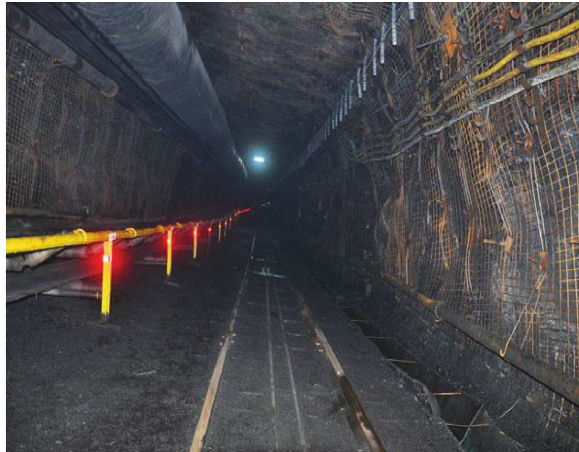
Figure 20: Stable section of the roadway.